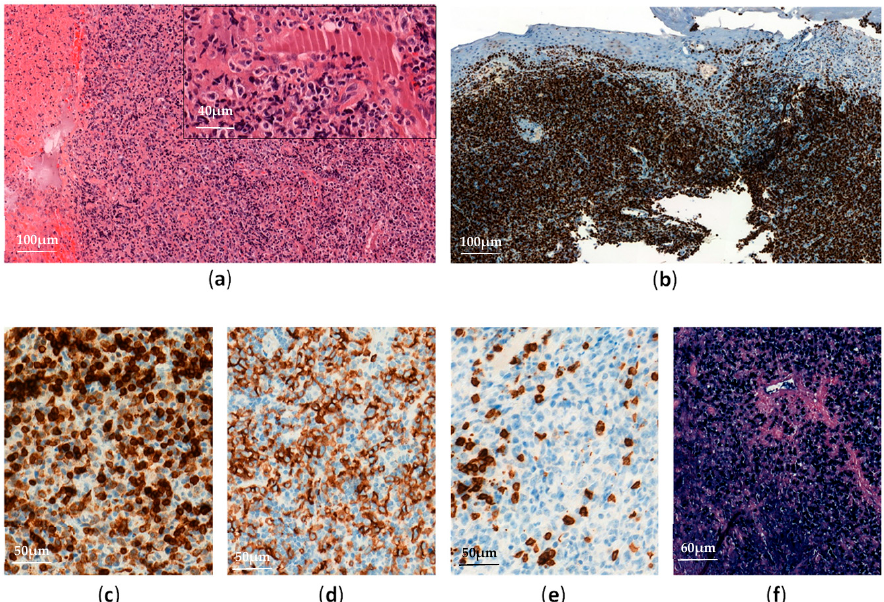
Figure 3. Extranodal NK/T-cell lymphoma, nasal type: ( a ) Nasal mucosa biopsy shows diffuse and expansive lymphoid infiltrate with necrosis (H&E, ×100 and ×400); ( b ) Ki67 immunostaining shows a high proliferative index (90%) of the atypical lymphoid infiltrate (×100); ( c – e ) The neoplastic cells are positive for CD3 ( c , ×300) and CD56 ( d , ×300), and negative for CD5 ( e , ×300); ( f ) EBV-encoded small RNA (EBER) in situ hybridization is positive in almost all neoplastic lymphoid cells (×200).